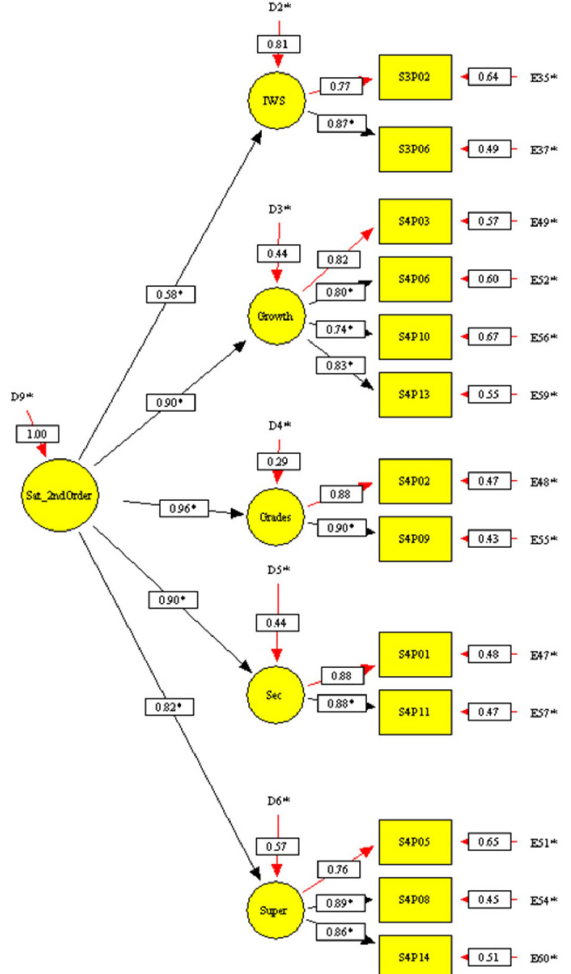
Figure 2. Respecified Model (Sat1 = Satisfaction; IWS = Internal work satisfaction; Grades = Satisfaction with grades; Sec = Satisfaction with security; Super = Satisfaction with supervision)